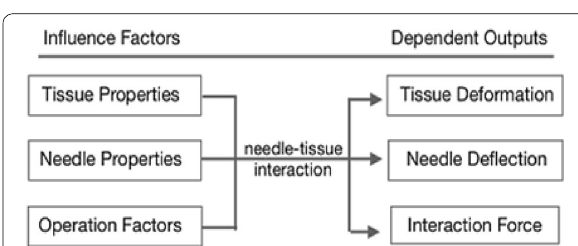
Figure 2 A schematic depiction of the influential factors that impact the results of phantom deformations, needle deflections and the interaction